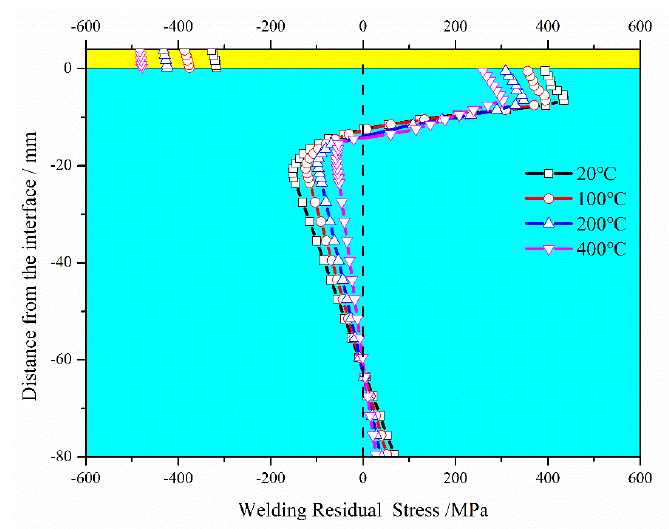
Figure 17. Final WRS with different substrate preheat temperatures levels.